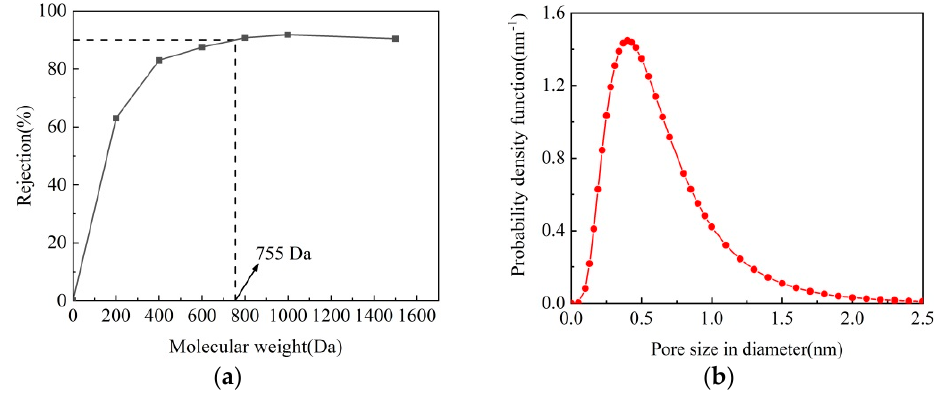
Figure 7. MWCO ( a ) and pore size distribution ( b ) of M5 membrane.